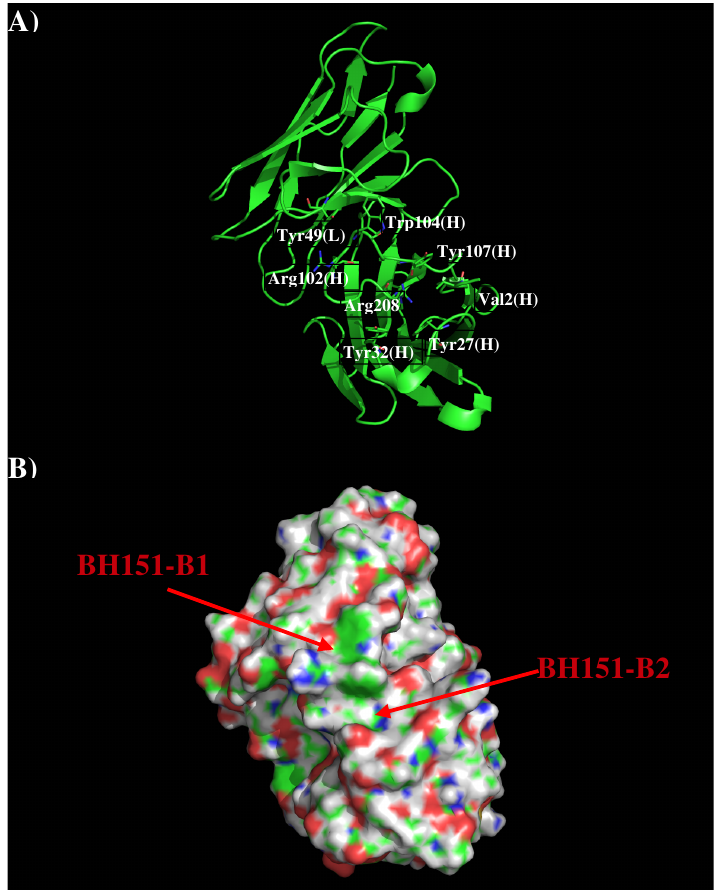
Figure 7. Model structure ( A ) and surface representation ( B ) of antibody BH151. Residues for the antibody interactions are shown in stick representation in ( A ). (L) and (H) denote the VL and VH domain of the antibody respectively. The figure was prepared using PyMOL